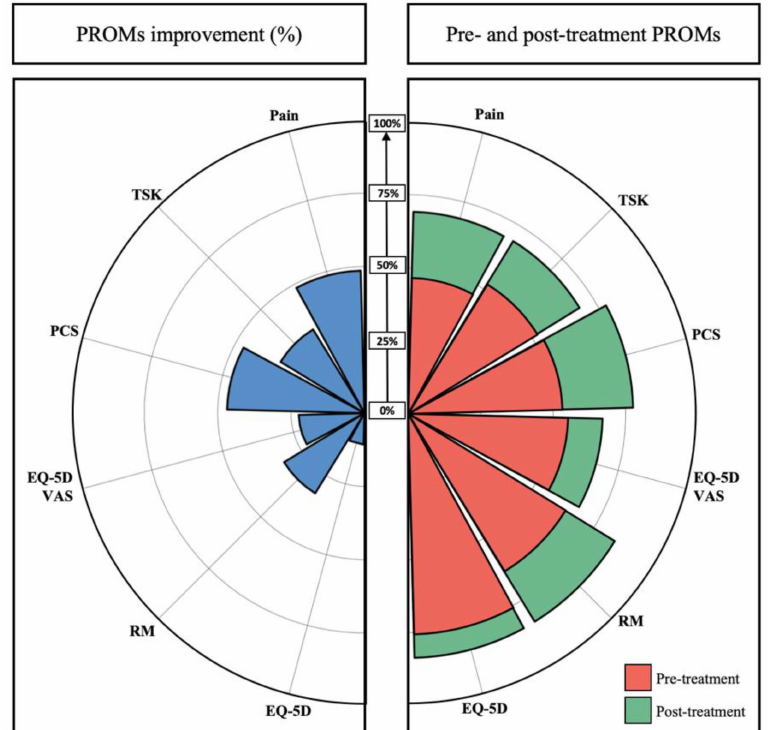
Figure 2. Radar chart illustrating the pre- and post-treatment patient status (right side) and the difference in % (left side). Each score was adjusted so that their minimal and maximal values were 0% and 100%, with a greater value indicating a better health status. VAS, visual analog scale; PGIC, Patients’ Global Impression of Change; TSK, Tampa Scale of Kinesiophobia; PCS, pain catastrophizing scale; RM, Roland–Morris; EQ-5D, EuroQol 5